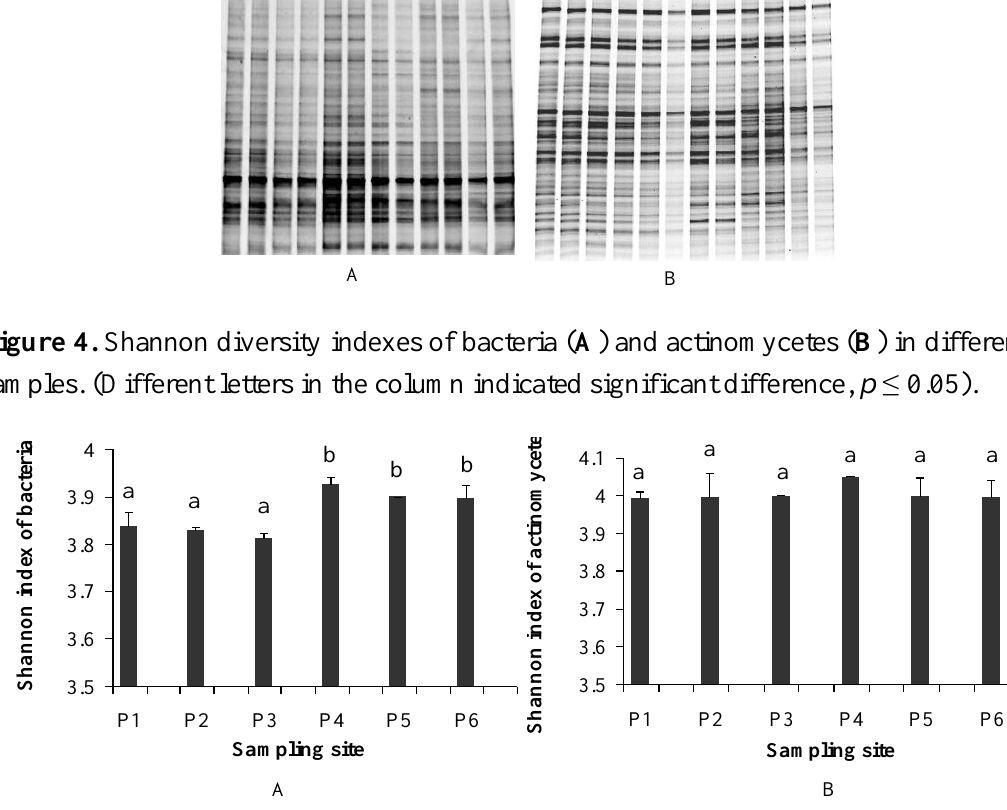
Figure 5. PCA analysis results based on DGGE profiles of paddy soil samples (( A ): bacteria, ( B ):